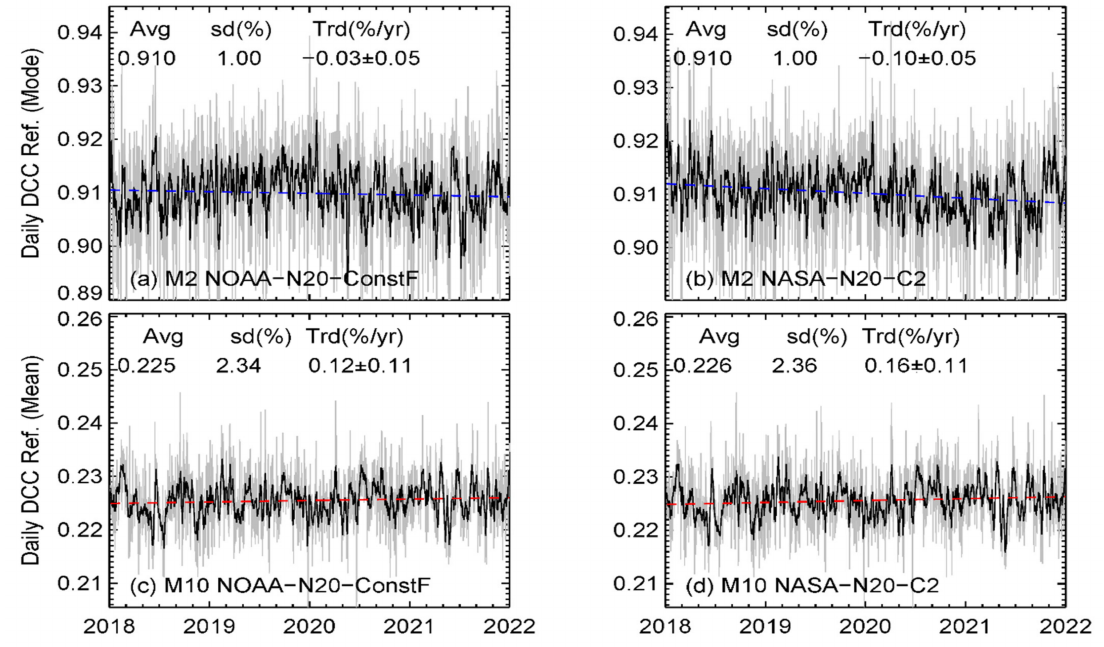
Figure 6. Examples of daily DCC time series for NOAA-20 VIIRS M2 and M10. Raw daily DCC time series are shown by gray lines. Black lines are moving averages with a window size of 7 days. Linear regression trends are shown as blue (downward trend) or red (upward trend) dashed lines.